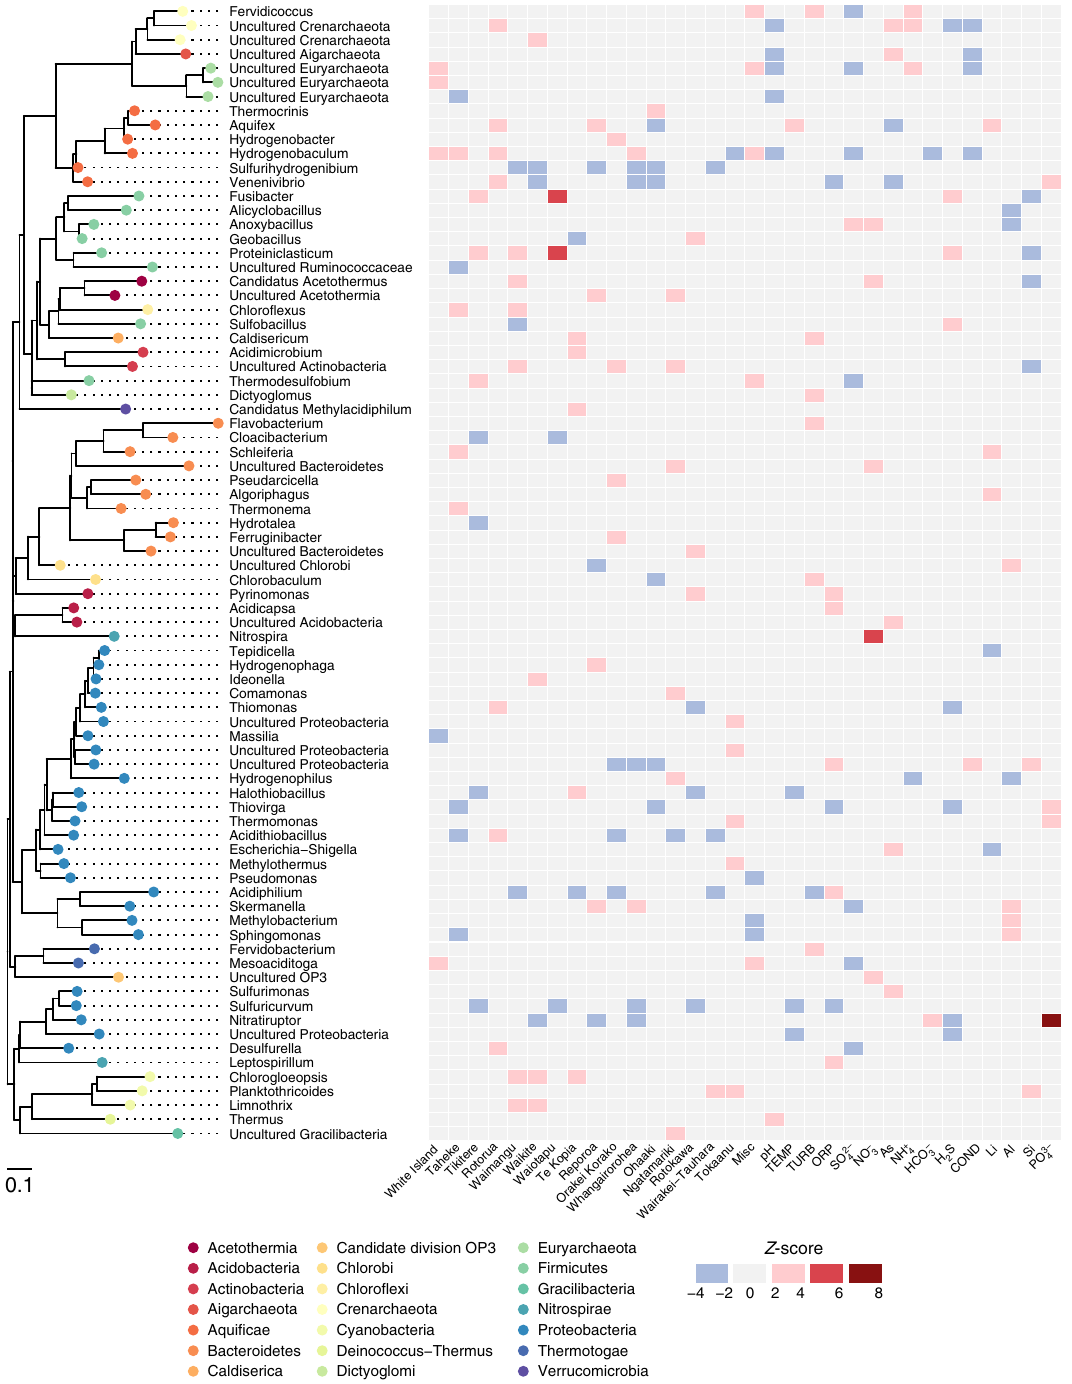
Fig. 5 Taxonomic association with location and physicochemistry. The heat map displays positive (red) and negative (blue) association of genus-level taxa (> 0.1% average relative abundance) with each geothermal fi eld and signi fi cant environmental variables, based on Z -scores of abundance log ratios. Each taxon is colour-coded to corresponding phylum on the approximately maximum-likelihood phylogenetic clustering of microbial communities (95% CI; Fig. 3 and communities for these sites clustering independently in ordina- Supplementary Fig. 8). Further, characteristic geochemical tion space. Despite this association, intra- fi eld variation in both signatures from these fi elds were identi fi ed and analysis suggests alpha and beta diversity also occurred at other geothermal sites they could be predictive of community composition. For where geochemical signatures were not uniform across local example, the Rotokawa and Waikite geothermal fi elds (approx. springs (e.g. Rotorua, Fig. 3 position D), demonstrating that 35 km apart) (Fig. 3 position N and F) display opposing ratios of correlation does not necessarily always occur between locational HCO (cid:1) , SO 2 (cid:1) , and Cl − , with corresponding microbial proximity and physicochemistry. 3 4